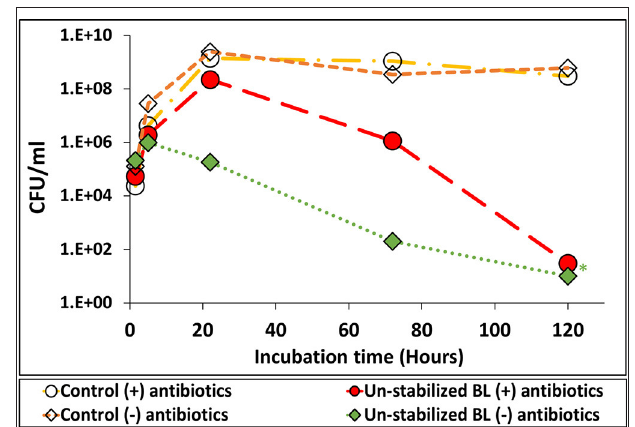
FIGURE 7 | The efect of antibiotics-induced inactivation of indigenous microbial populations in broiler litter (BL) on S. Infantis multiplication. Growth of Salmonella in nutrient broth suspension of un-stabilized BL, which was amended or not amended with a cocktail of antibiotics to which the pathogen is resistant. *Values below the detection limit without enrichment (10 CFU ml − 1